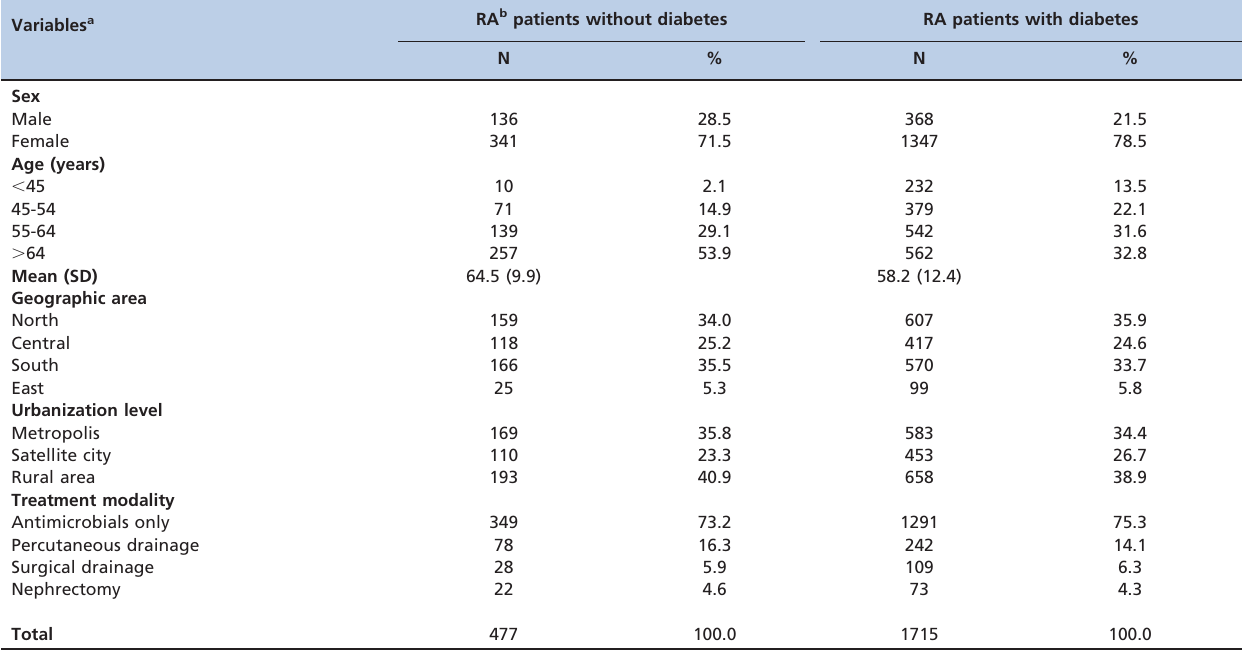
Table 1 - Characteristics of patients with renal or perinephric abscess according to diabetic status. Variables a